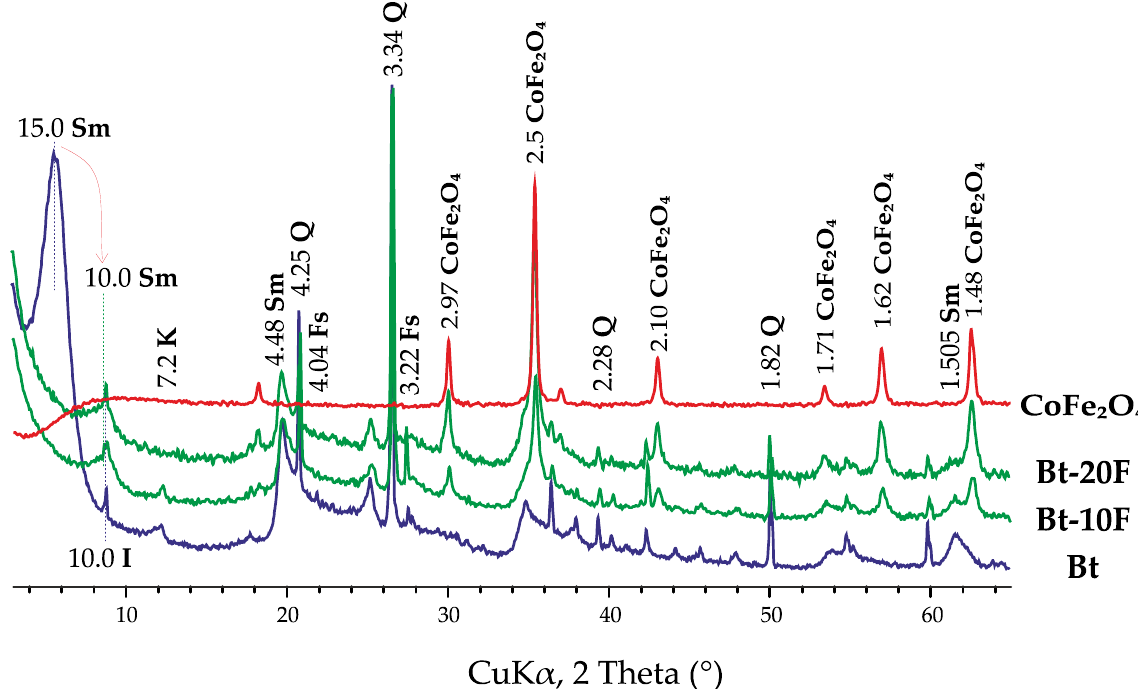
Figure 1. XRD patterns of investigated samples of Bt, CoFe 2 O 4 and composites Bt-10F,